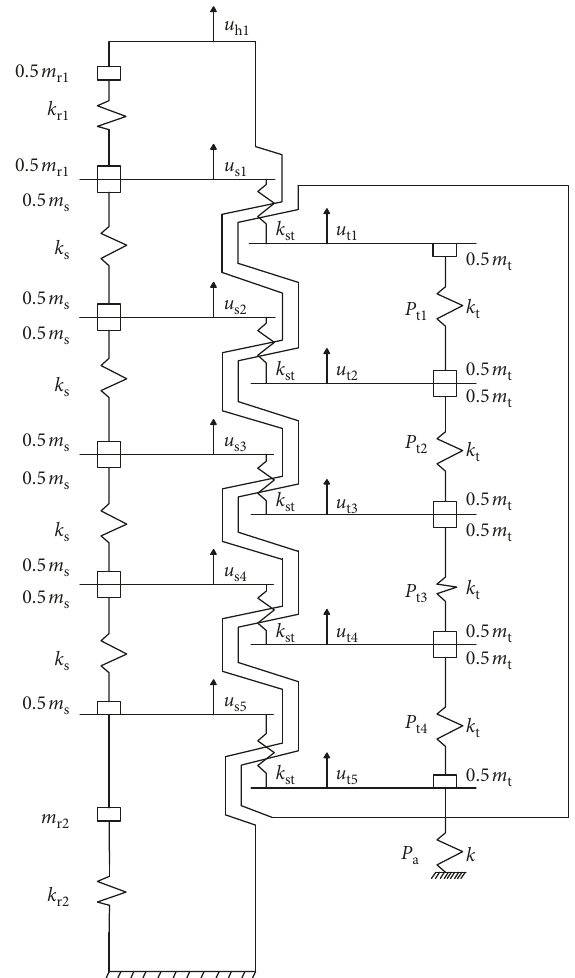
Figure 3: Developed model for discrete mechanical